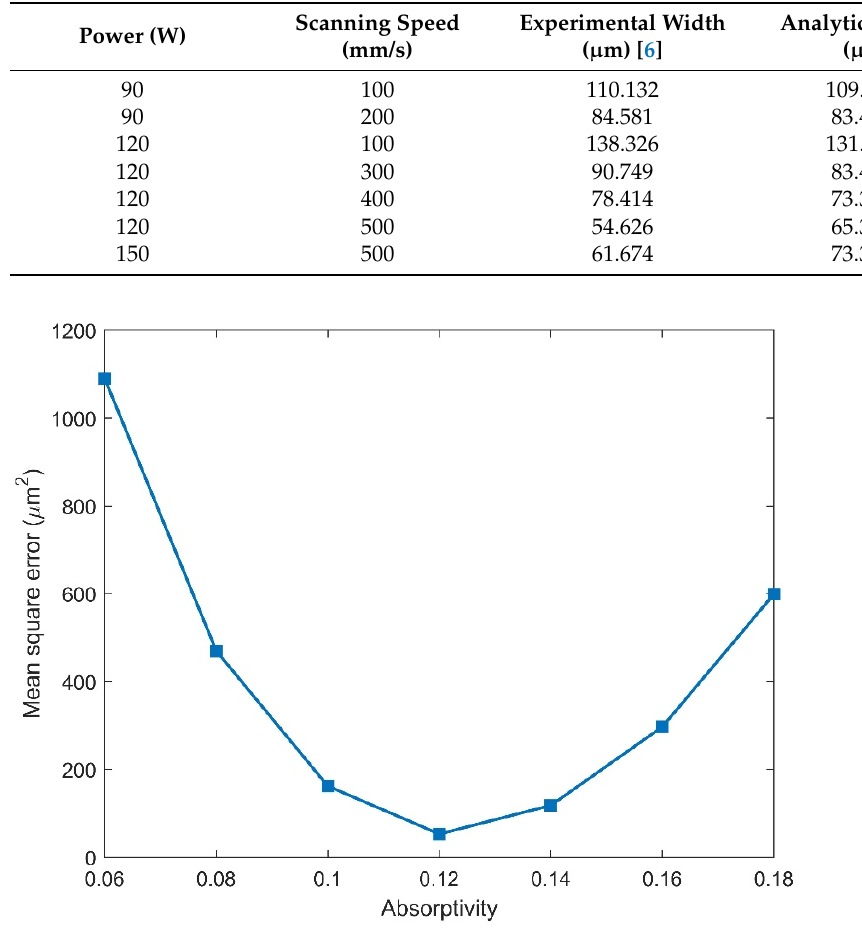
Figure 6. Sensitivity of mean square error to laser absorptivity for molten width